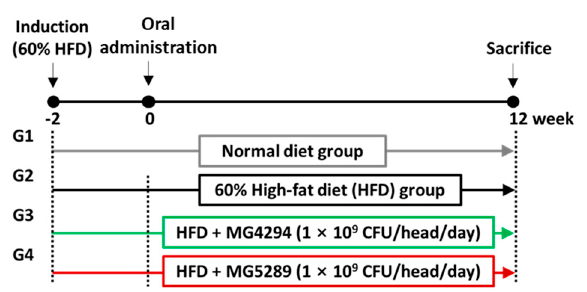
Figure 1. Animal experimental design for the e ff ect of probiotics on NAFLD—induced mice ( n = 6 per